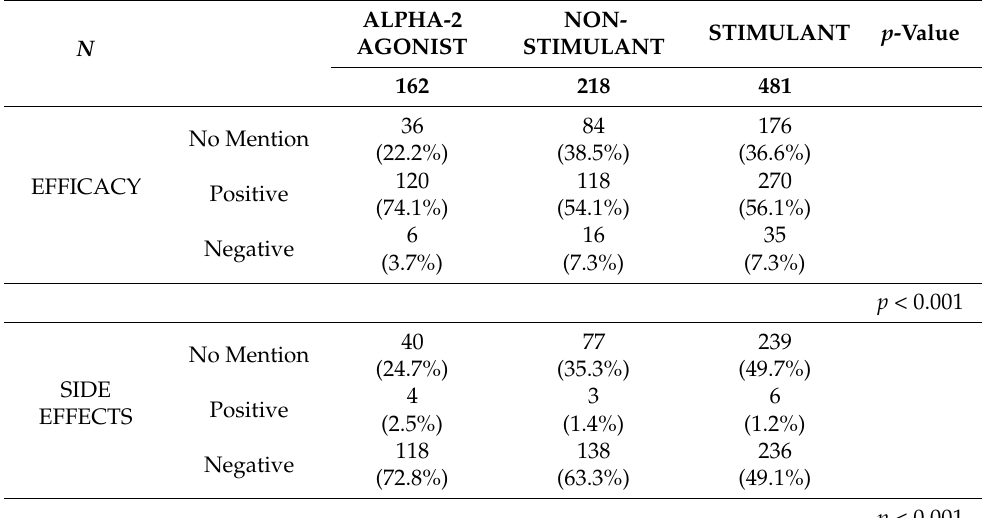
Table 2. Descriptive characteristics of the tweets considered classifiable in the content analysis, categorized by total amount per drug and